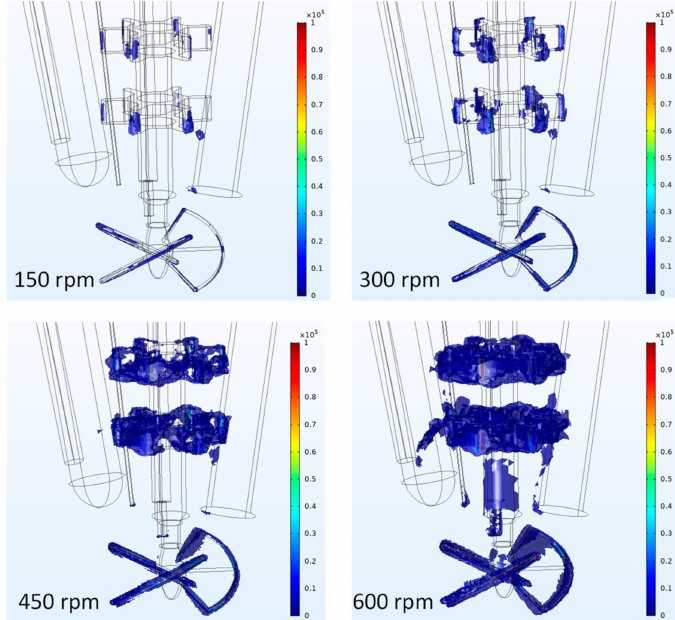
Figure A4. Areas in the TIS with energy dissipation rates above 1000 W m − 3 .